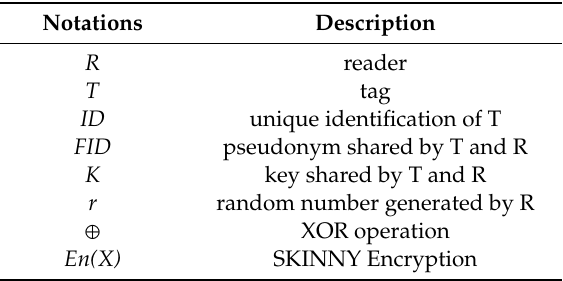
Table 1. The description of notations.